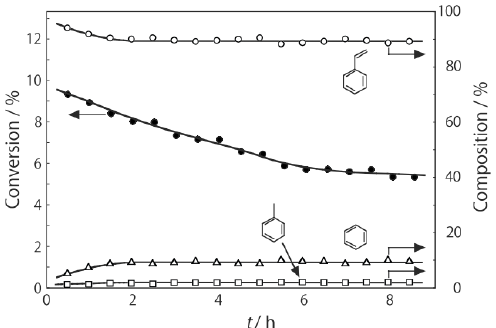
Figure 1. Typical reaction profile of ethylbenzene dehydrogenation catalyzed by (H O) [(Mo Cl )Cl ]·6H O. Following activation of the cluster (200 mg, 0.163 mmol) in 3 2 6 8 6 2 a helium stream (600 mL/h) at 450 °C for 1 h, reaction was initiated by introduction of ethylbenzene (50 μL/h, 0.4 mmol/h) to the helium stream without changing the temperature. Conversion = products/(products + recovered material) × 100 (%) based on aromatic